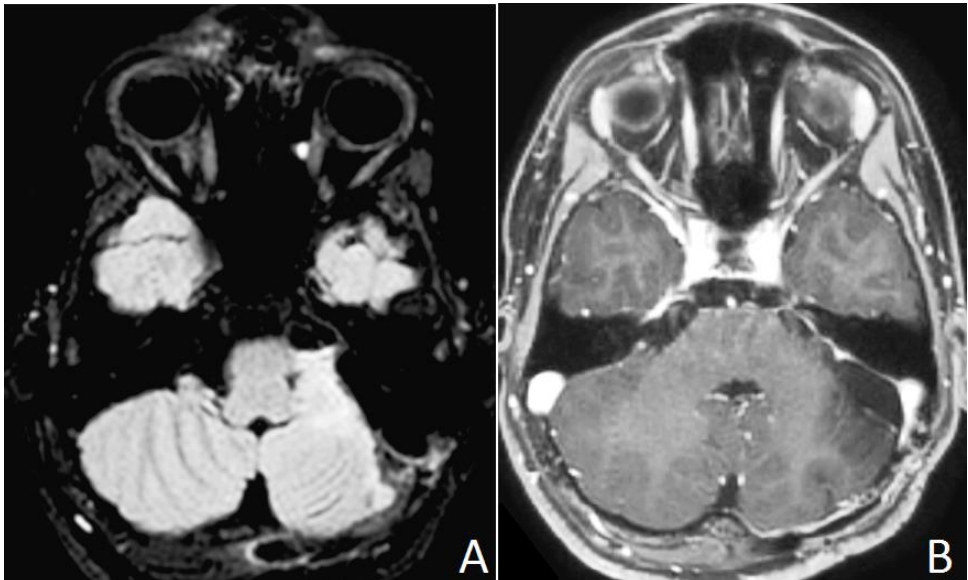
Figure 2. Postoperative brain MR images. A residual infiltration in the upper portion of the middle cerebellar peduncle is evident in axial FLAIR T2 weighted images ( A ). No residual contrast enhancement is evident after gadolinium administration in T1 weighted images ( B ).